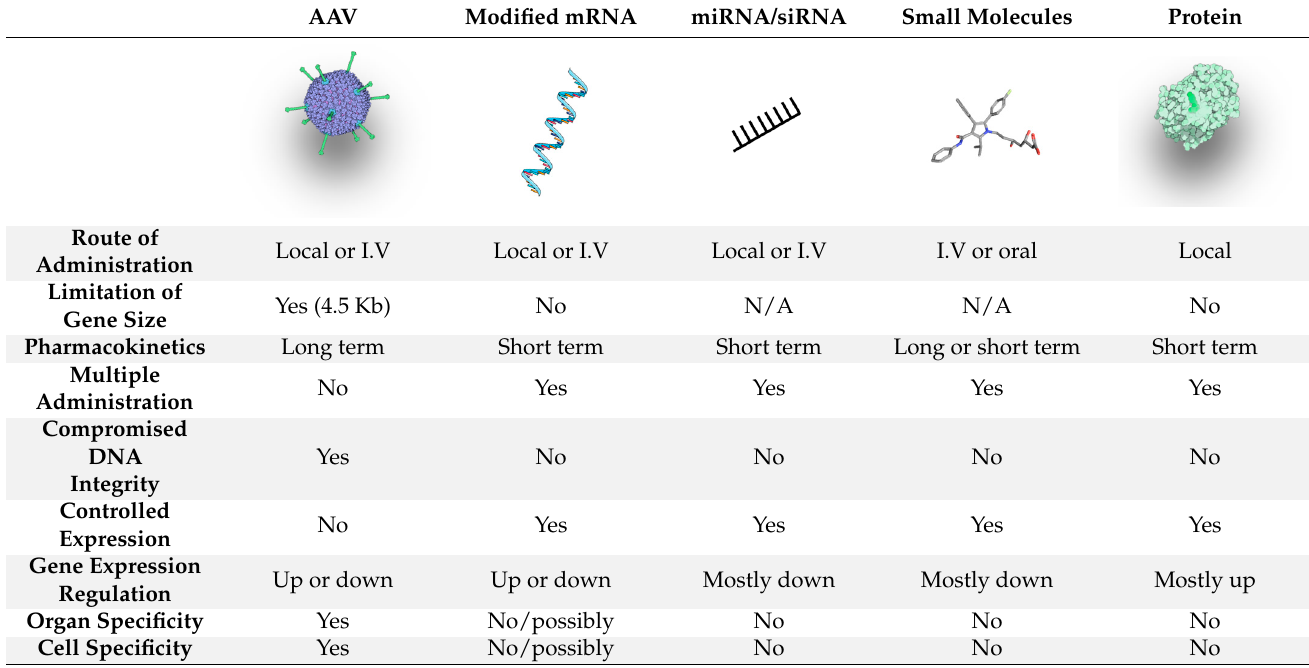
Table 1. Tools for therapeutic manipulation of protein levels in tissues.